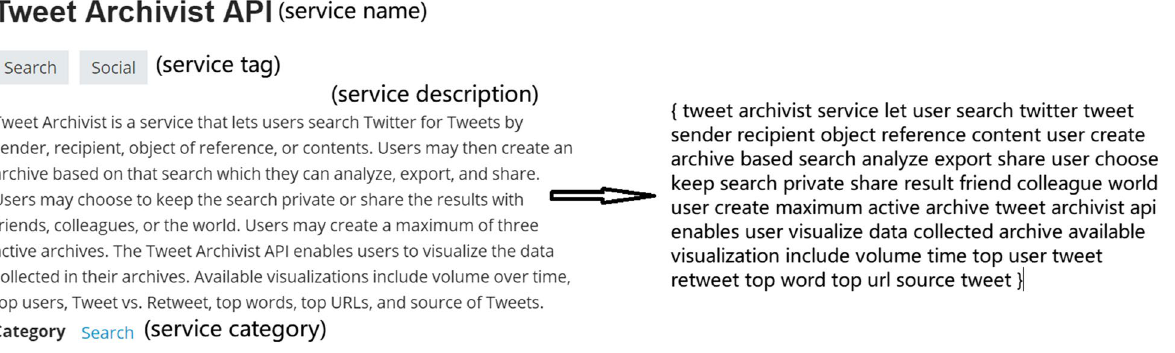
Fig. 4 An example of Web API